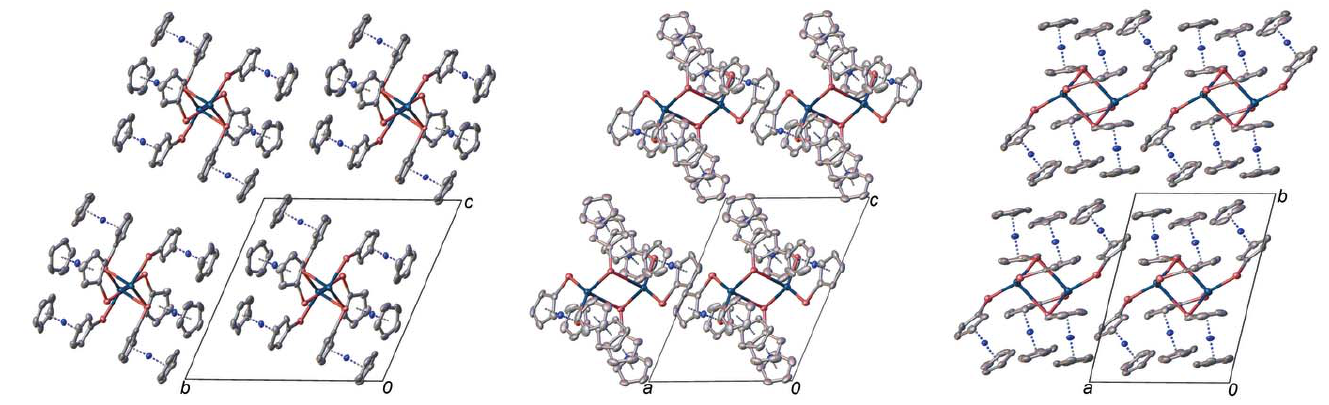
Figure 2 Molecular packing in the title compound with displacement ellipsoids drawn at the 50% probability level in views along the a (left) , b (center) and c (right) axes. Hydrogen atoms, anions and solvent molecules are omitted for clarity.